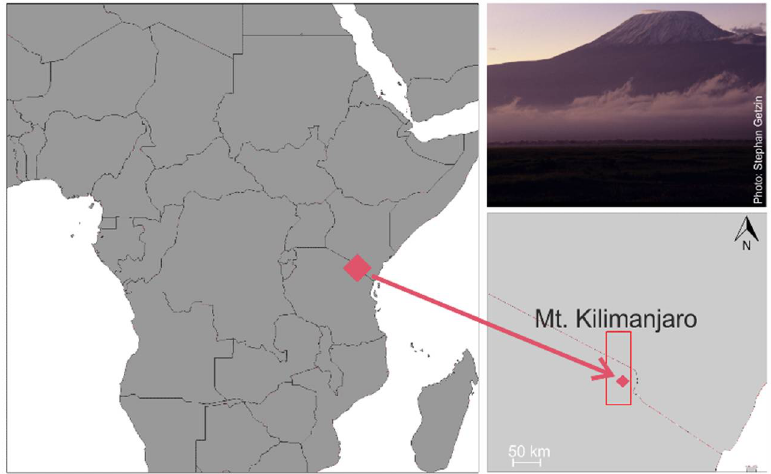
Figure 1. Map showing the location of the study region at Mt. Kilimanjaro in Tanzania, Africa. The red dot represents the location of the study site; the red rectangle indicates the area investigated with the satellite data (MODIS burned area, see Section 2.5). Photo: Stephan Getzin.